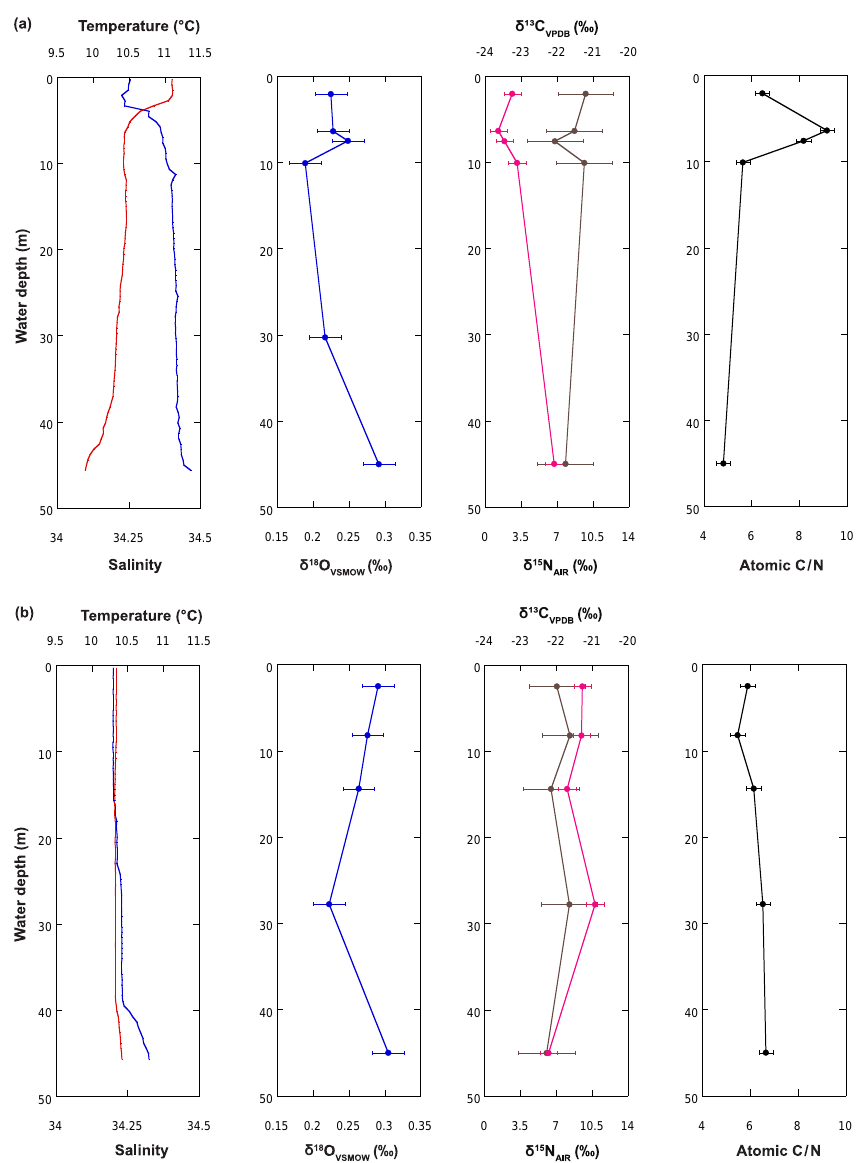
Figure 4. Profiles of modern fjord water temperature, salinity, δ 18 O and δ 13 C, δ 15 N, and atomic C / N of acidified particulate organic matter (OM) sampled in February 2015, representing end-member synoptic weather conditions. (a) CTD_007 (Hanfield Inlet) was sampled when a high-pressure system had been situated over the Auckland Islands for >24h and is representative of profiles collected under fair weather conditions (low wind velocities, no precipitation). Under these conditions, the water column exhibits weak stratification. Temperature is slightly elevated and salinity is slightly depressed in the upper 4m of the water column, and δ 18 O is more positive in the upper ∼ 10m. Particulate OM δ 15 N shows an overall increase with depth, while δ 13 C and molecular C / N show a decrease. (b) CTD_006 (Norman Inlet) was sampled when a low-pressure system was in the vicinity of the Auckland Islands, producing high W/SW wind velocities and precipitation. Under these conditions, the water column is completely mixed. Temperature and salinity are largely invariant with depth and increase only slightly below 40m, while particulate OM δ 13 C, δ 15 N, and atomic C / N are invariant within error. Error bars are the average standard deviation of duplicates for each CTD cast ( δ 18 O) and for all filtered particulates ( δ 13 C, δ 15 N, and C /